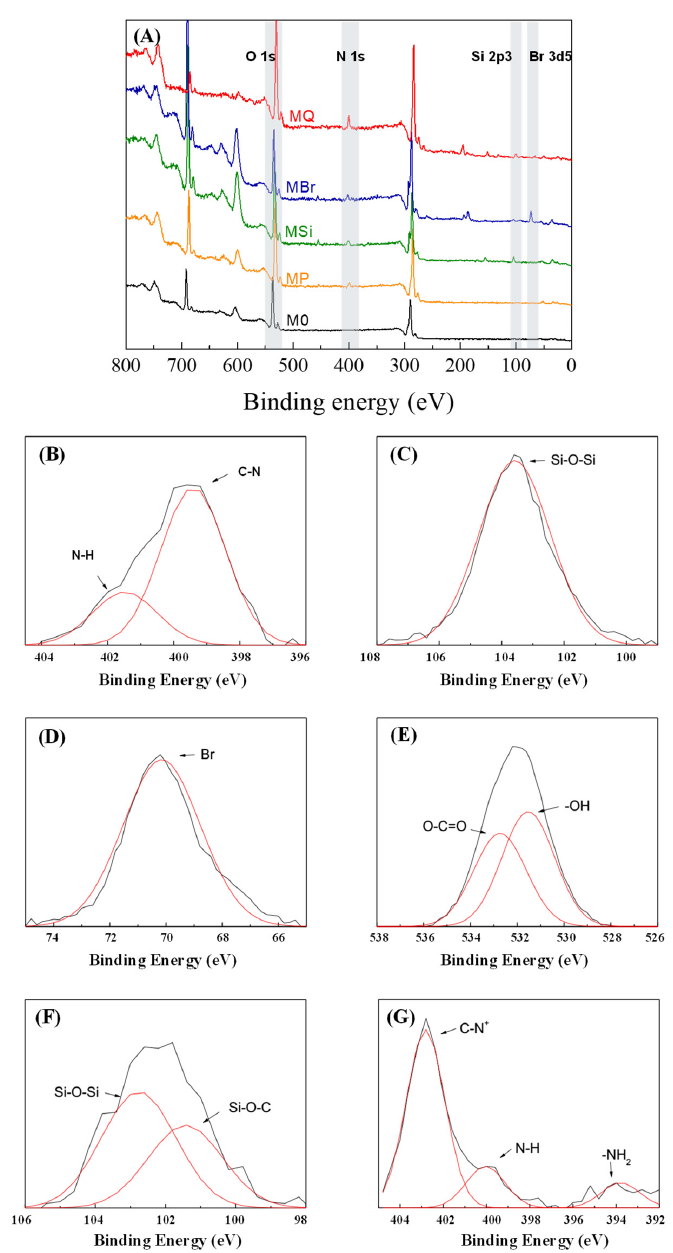
Figure 2. ( A ) XPS spectra. High-resolution XPS spectra of ( B ) N 1s of MP, ( C ) Si 2p3 of MSi, ( D ) Br 3d5 of MBr, ( E ) O 1s of MBr, ( F ) Si 2p3 of MBr and ( G ) N 1s of MQ. ATR-FTIR spectra (Figure 3 A,B) of membranes (i.e., M0, MP, MSi, MBr and MQ) also confirmed